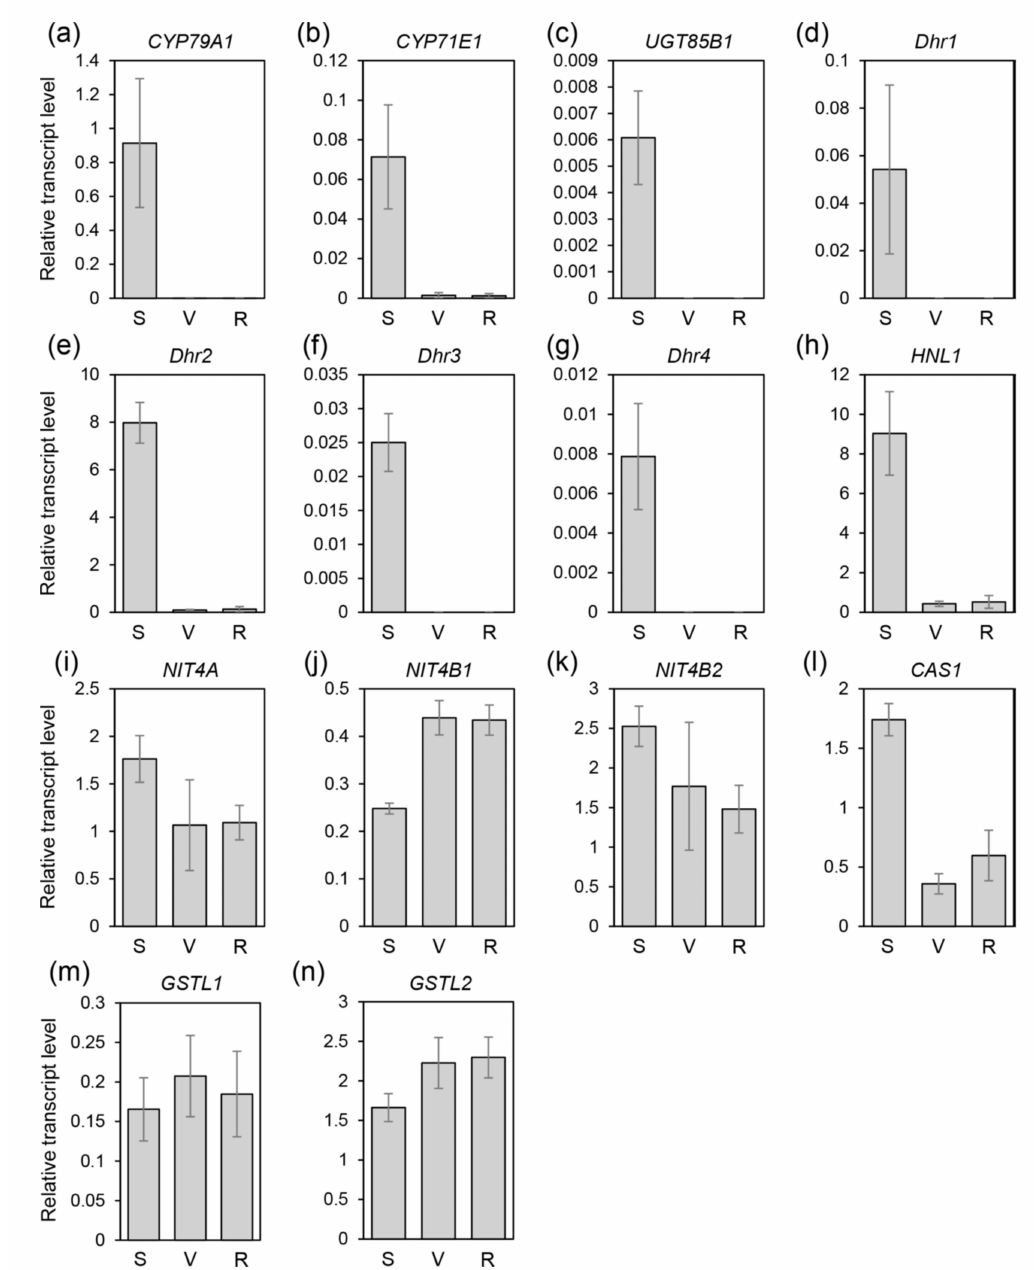
Figure 5. Expression patterns of candidate genes for dhurrin metabolism according to di ff erent developmental stages in BTx623. Quantitative real-time RT-PCR analyses of ( a ) CYP79A1 , ( b ) CYP71E1 , ( c ) UGT85B1 , ( d ) Dhr1 , ( e ) Dhr2 , ( f ) Dhr3 , ( g ) Dhr4 , ( h ) HNL1 , ( i ) NIT4A , ( j ) NIT4B1 , ( k ) NIT4B2 , ( l ) CAS1 , ( m ) GSTL1 , ( n ) GSTL2 . Y -axis, transcript level relative to sorghum PP2A expression. X